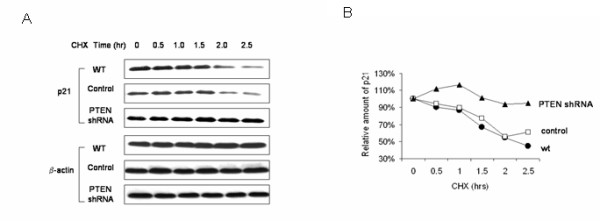
The stability of p21 is increased by PTEN-knockdown. a. Wild type ACHN cells as well as those stablytransfected with PTEN-shRNA or empty vector control were incubated with cycloheximide (CHX; 20 μg/ml) for the times indicated and immunoblotted with antibodies against p21 and β-actin. b. Graphical representation of the data from densitometric quantification of p21 and β-actin reported as ratio of p21/β-actin and normalized to the "0 CHX control" for each lane. A representative experiment of four done is shown.